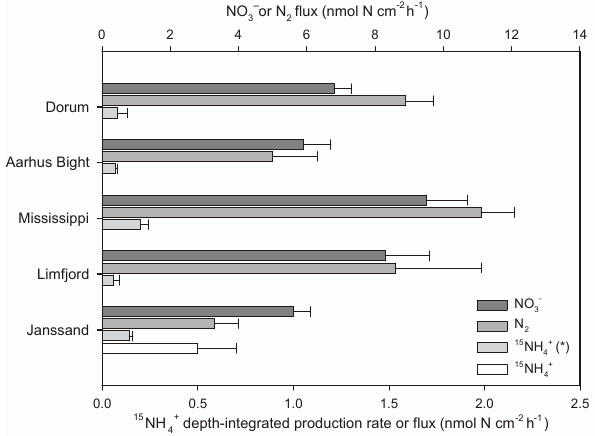
Fig. 2. Calculated NO − fluxes (from the sediment surface into the 3 layer of NO − reduction) and N 2 and 15 NH + fluxes (out of the layer 3 4 of N 2 and 15 NH + production) in intact sediment cores sampled 4 at different coastal marine investigation sites. ( ∗ ) Estimated from depth-integrated rates of 15 NH + production. Means + standard de- 4 viation of n = 4–12 profiles are